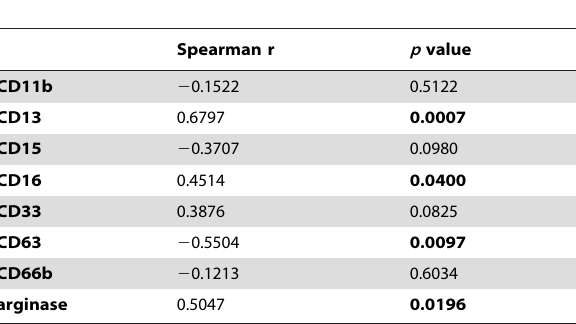
Table 3. NDGs: Correlation between CD4 + T cell counts and MFIs.